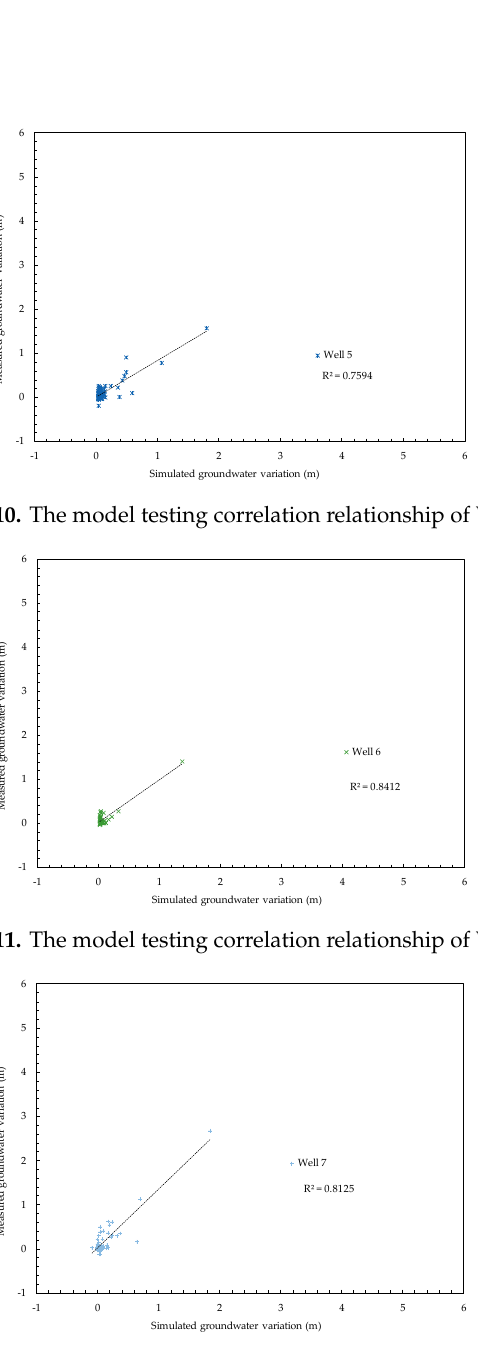
Figure 12. The model testing correlation relationship of Well 7.